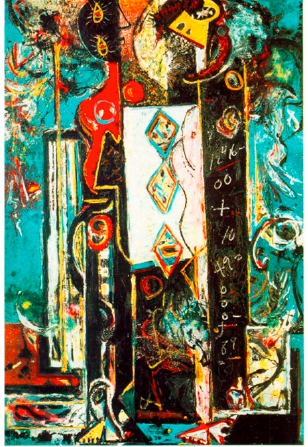
Figure 11. Jackson Pollock, Male and Female , ca. 1942, oil on canvas, 73 1/4 × 49 in. (186.1 × 124.3 cm). Philadelphia Museum of Art. Gift of Mr. and Mrs. H. Gates Lloyd, 1974. © 2022 The Pollock-Krasner Foundation/Artists Rights Society (ARS), New